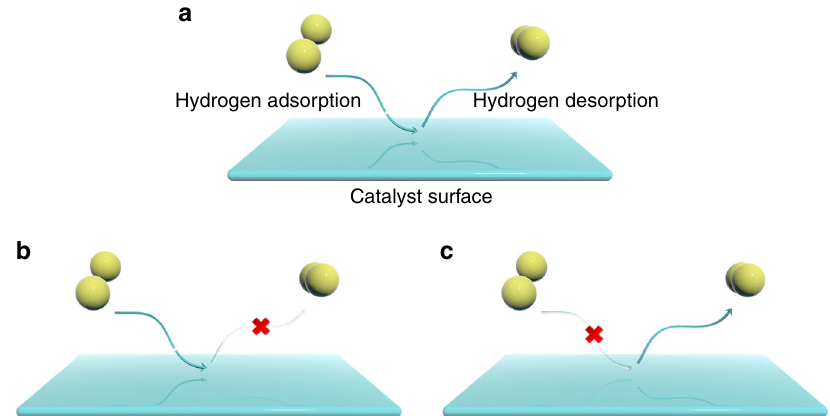
Fig. 1 Schematic illustration for the different hydrogen adsorption/desorption behaviors of catalyst surface. a Balanced hydrogen adsorption/desorption behavior. b , c Too strong and too weak hydrogen adsorptions, respectively, resulting in sluggish hydrogen evolution reaction rate. The dark yellow ball represents hydrogen atom